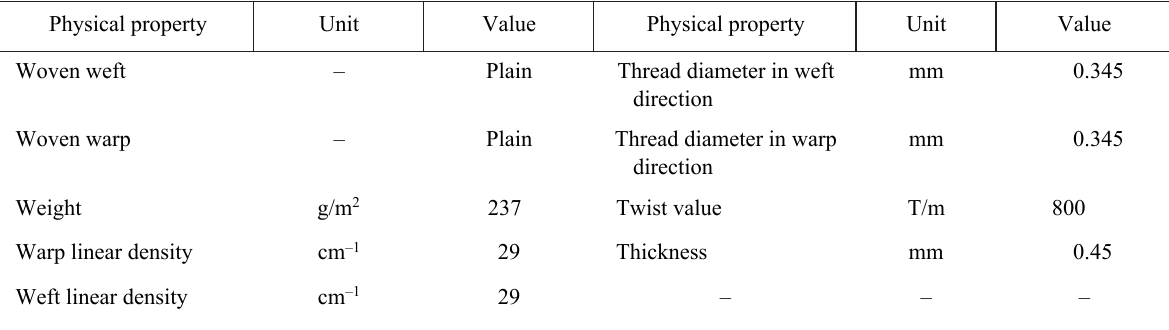
Table 1. Subjective assessment of post­consumer cotton